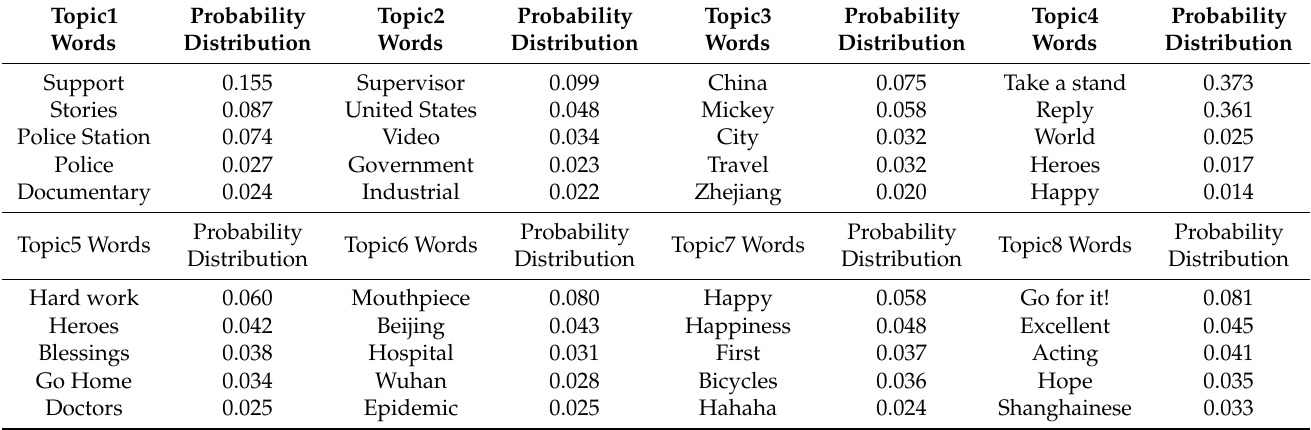
Table 9. A1 LDA theme model results.